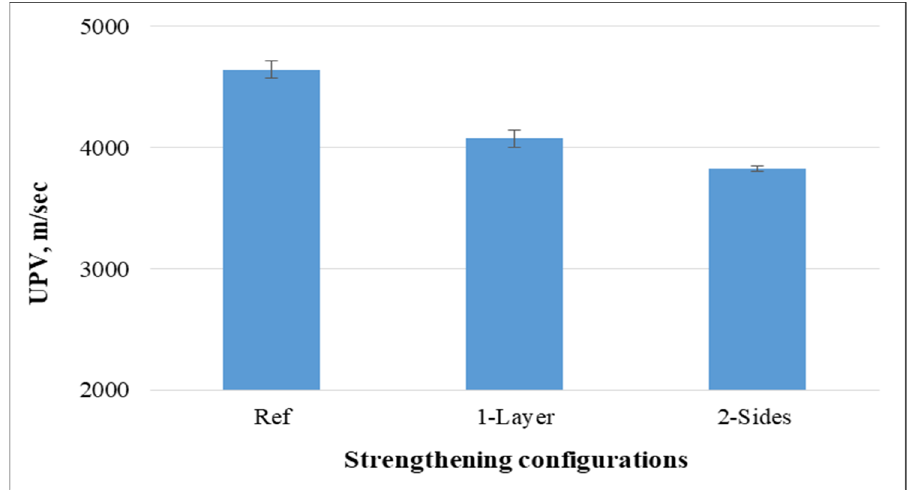
Figure 11. Ultrasonic pulse velocity of concrete.